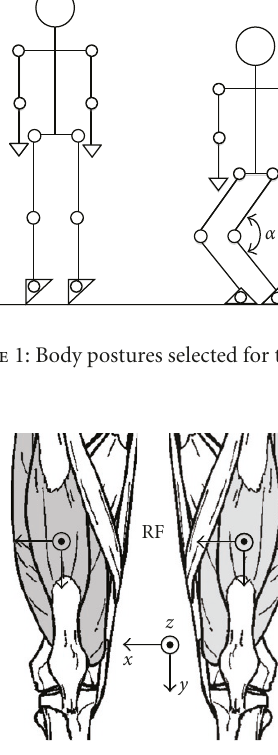
Figure 2: Example of accelerometer arrangement on muscles for both of the lower limbs. The picture shows the position and orientation of the accelerometer on RF muscles.